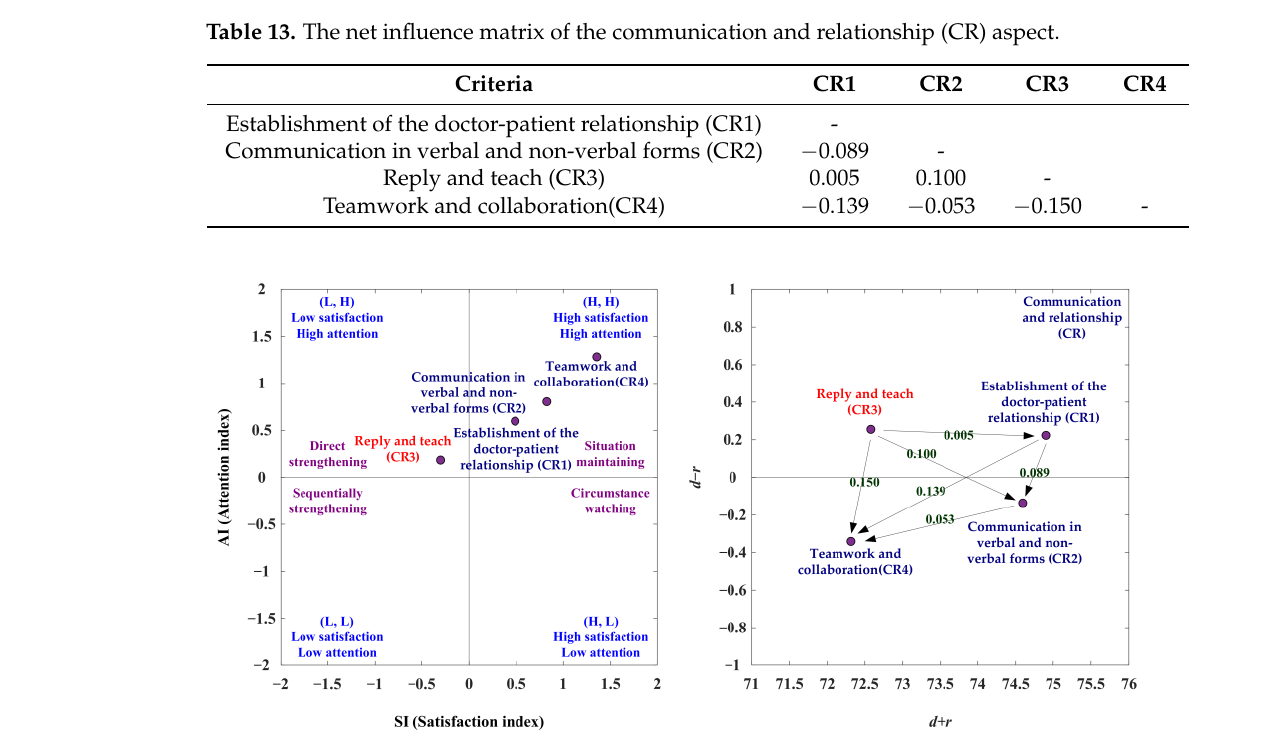
Table 13. The net influence matrix of the communication and relationship (CR) aspect. Criteria